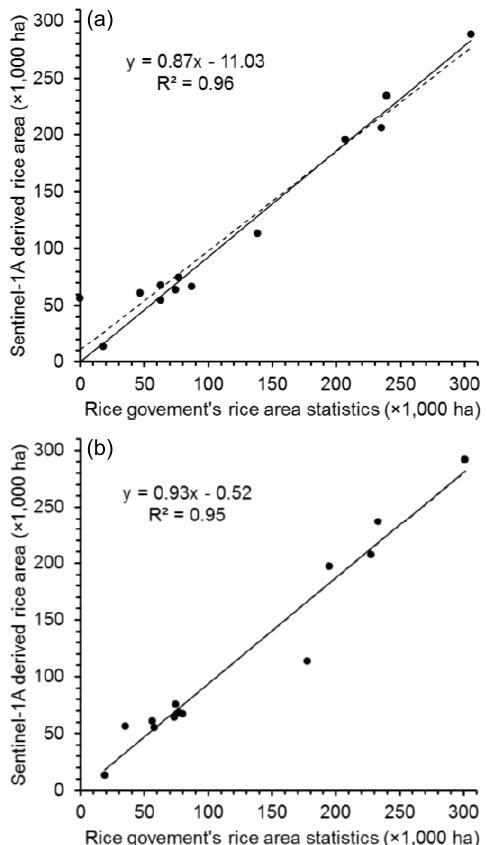
Figure 3. Correlation between the Sentinel-1A-derived rice area and the government’s rice area statistics: (a) winter–spring crop, and (b) summer–autumn